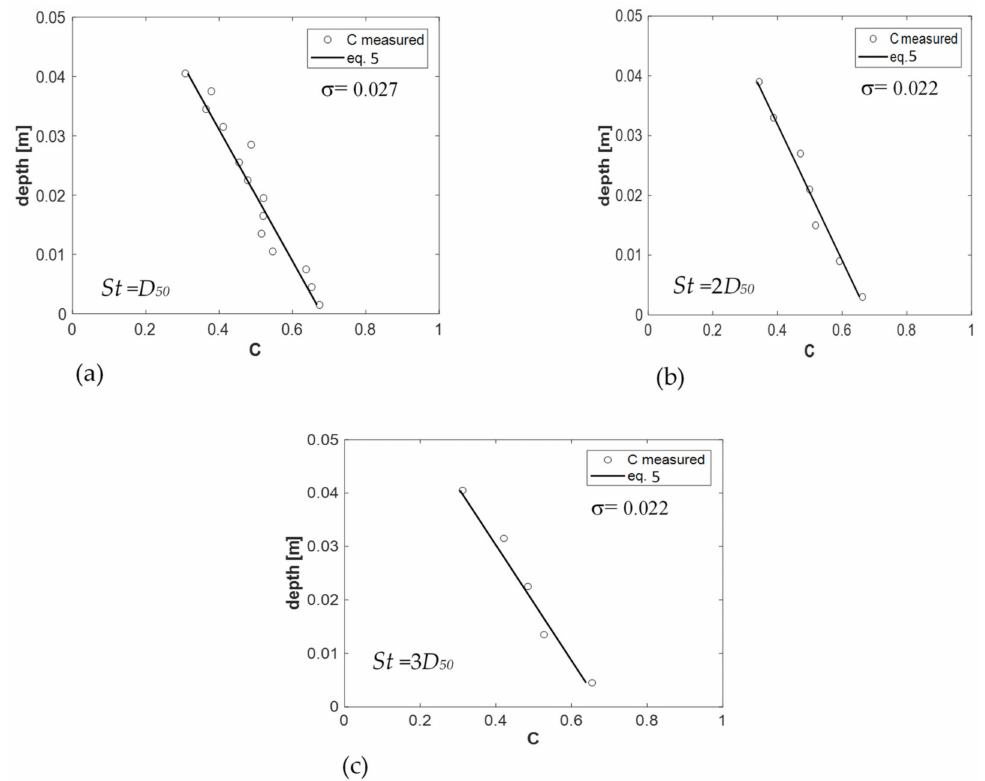
Figure 6. Comparison between the theoretical distribution of the grain concentration (Equation (5)) and the estimated values (C measured) by assuming di ff erent sub-layer thickness St : ( a ) for St = D 50 ; ( b ) for St = 2D 50 ; ( c ) for St = 3D 50 . The x -axis indicates the grain concentration; the y -axis indicates the distance from the upper level of the static